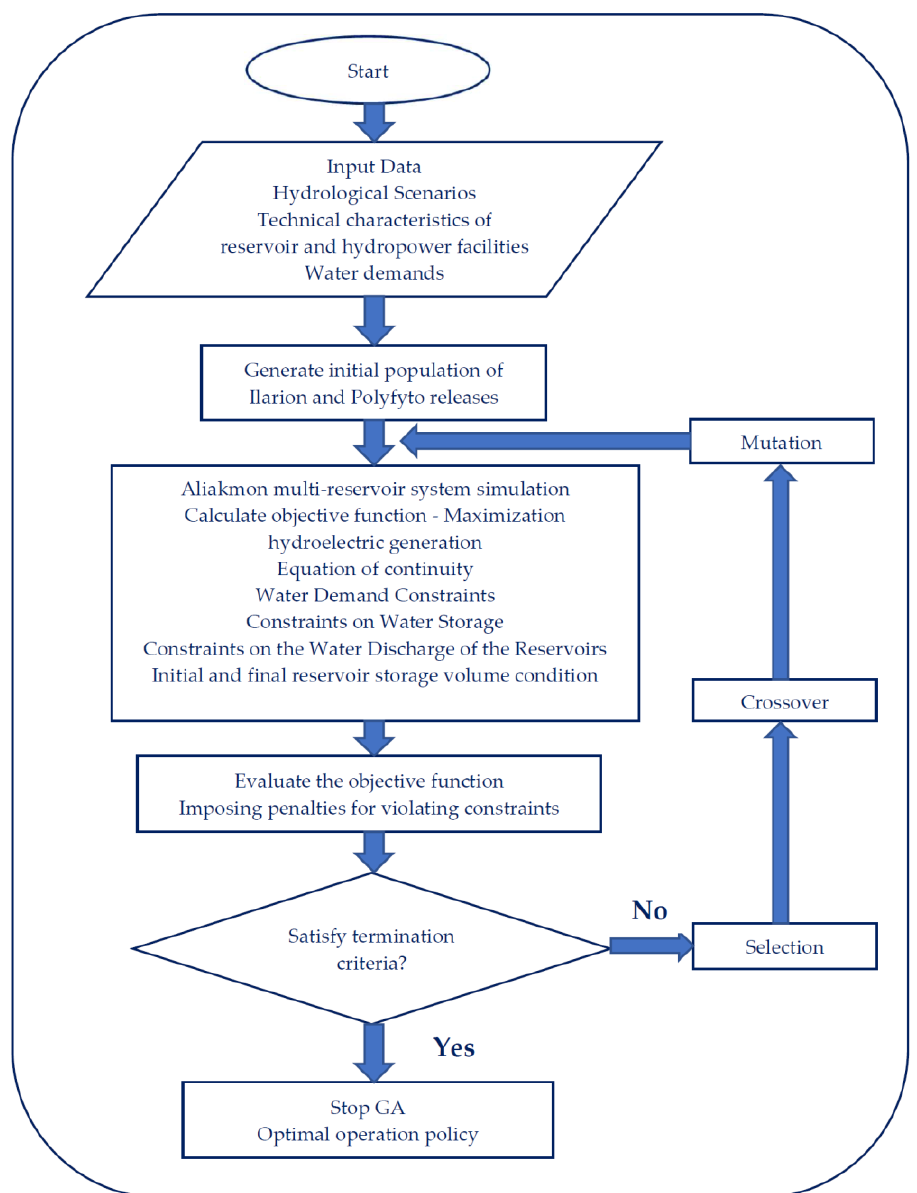
Figure 4. Conceptual framework and flow chart of the proposed GAs-based Simulation- Optimization Model of the hydropower system of Aliakmon River.